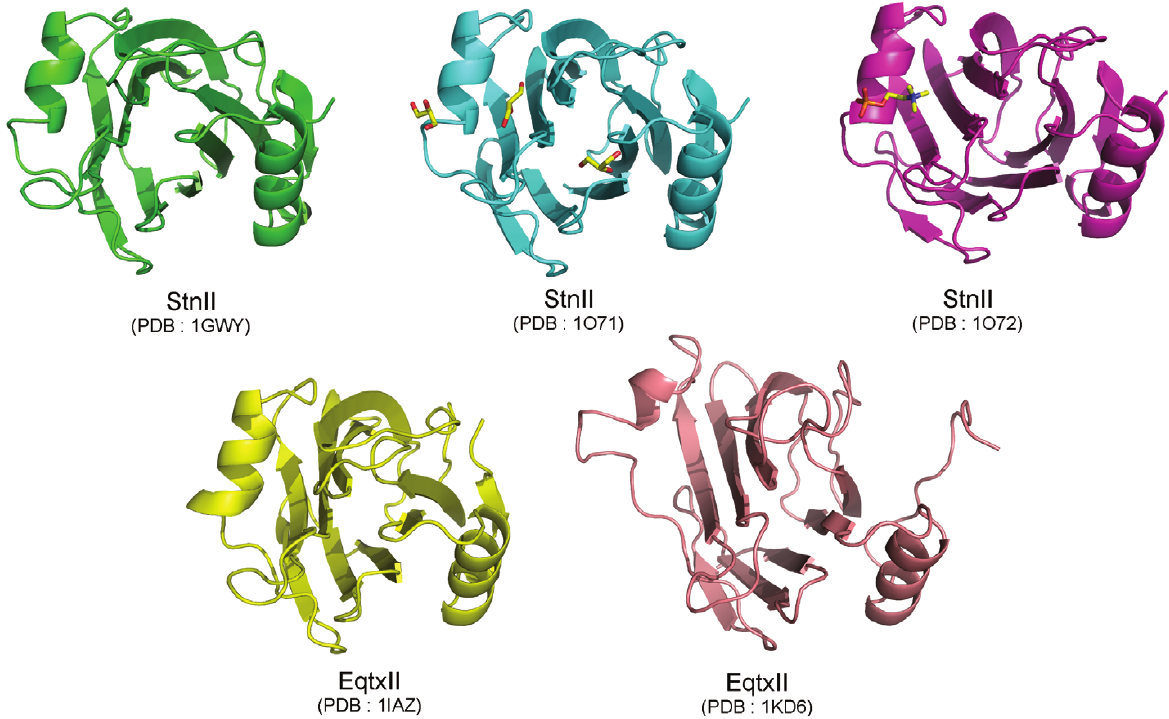
Figure 1 - Comparison between all atomic structures of actinoporins available. Crystal structure of StnII (PDB ID 1GWY), crystal structure of StnII complex with glycerol (PDB ID 1O71), crystal structure of StnII complex with phosphorylcholine (PDB ID 1O72), crystal structure of EqtxII (PDB ID 1IAZ) and NMR structure of EqtxII (PDB ID